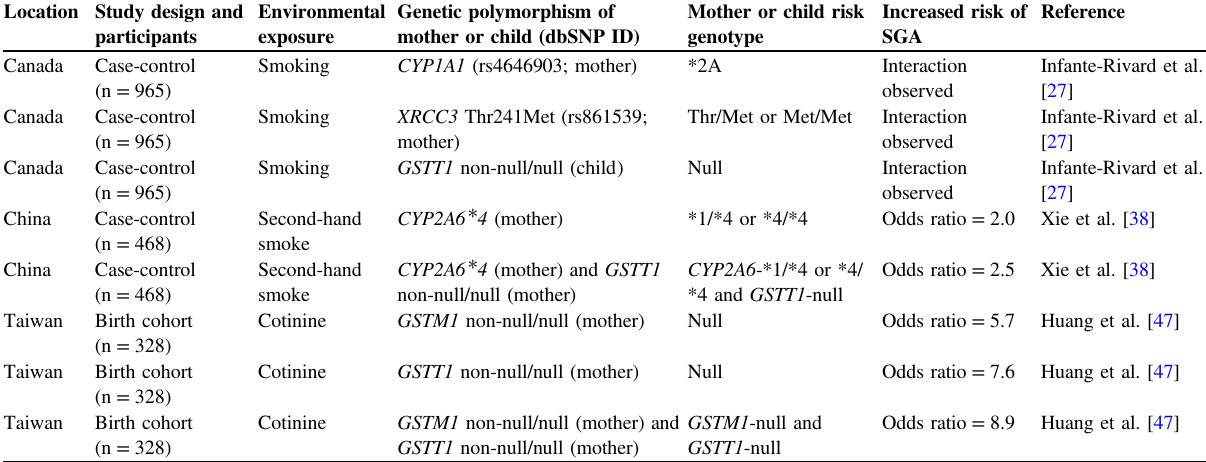
Table 5 Maternal smoking during pregnancy and increased risk of small-for-gestational-age (SGA) fetuses Location Study design and